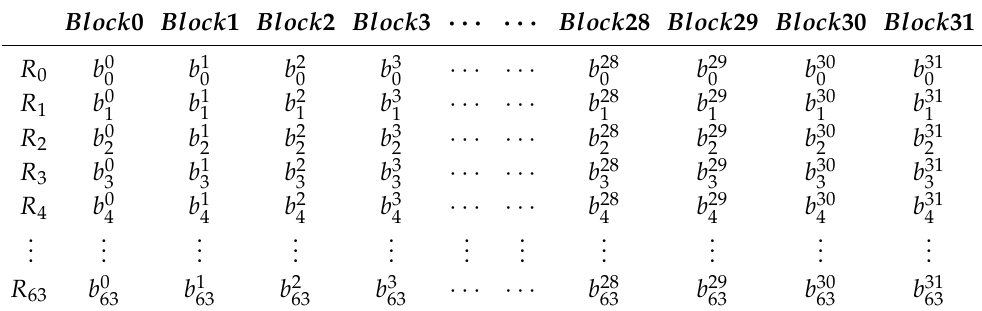
Table 1. Bit-slicing representation from using 64 32-bit registers R 0 , ..., R 5 to process 32 blocks b 0 , . . . , b 7 in parallel where b i refers to the j -th bit of the i -th j